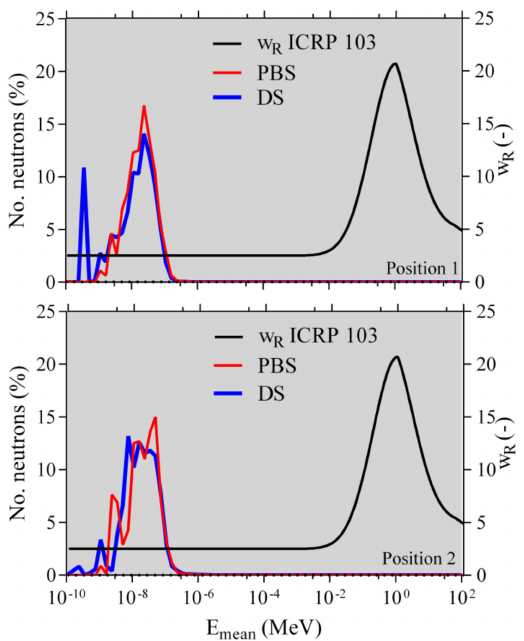
Figure 1. The normalized neutron spectra (the total number of neutrons is taken as 100%, as is shown in Tables 2 and 3) and the representation of the radiation weighting factors (w R ) according to the ICRP Publication 103 [22].